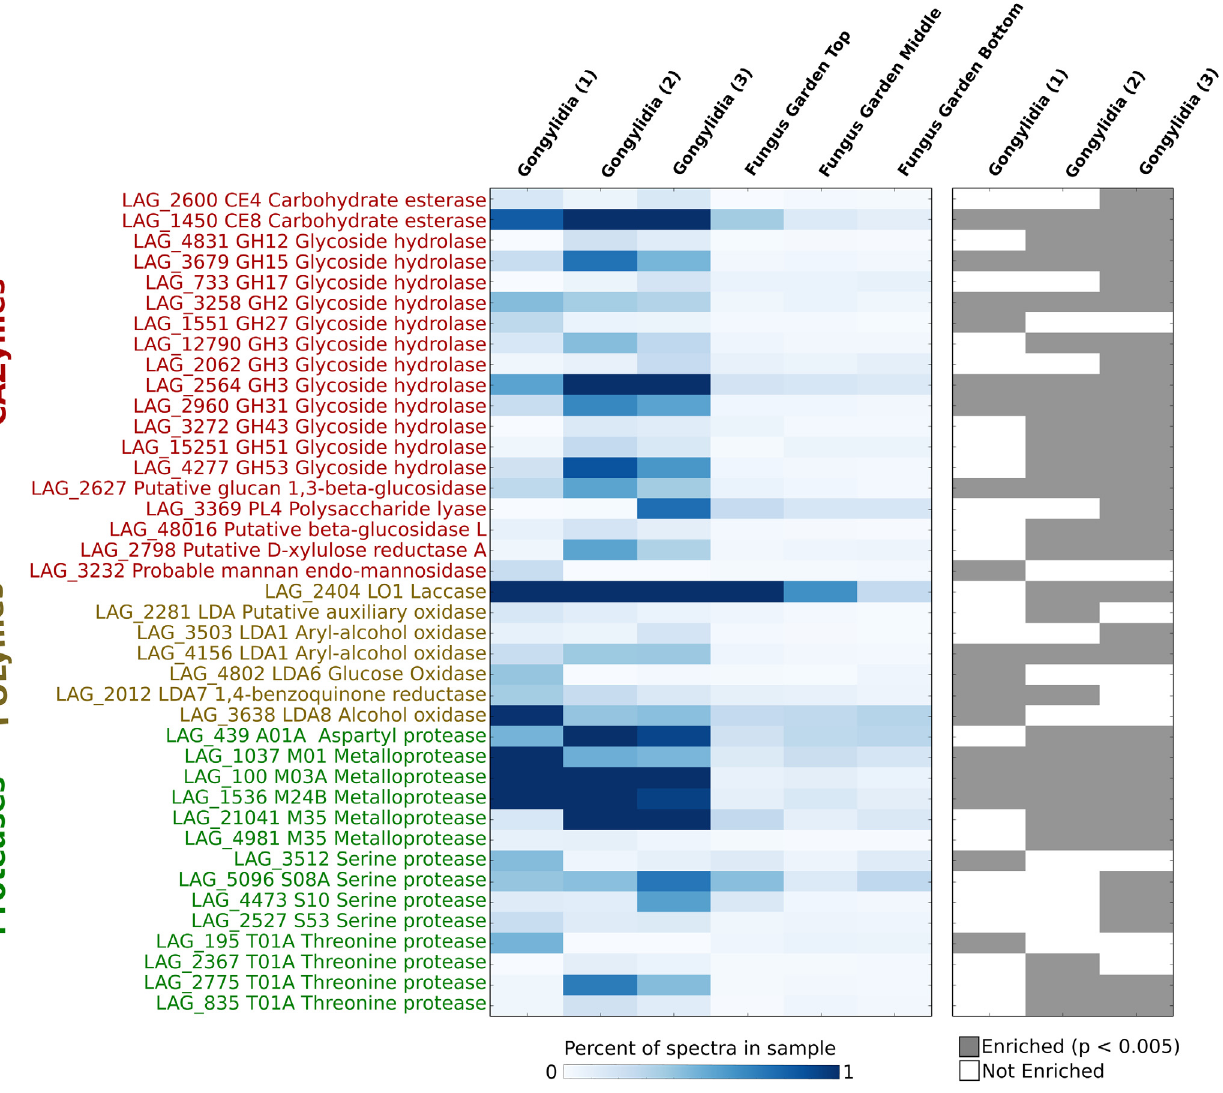
Fig 4. Heatmaps are presented that show the relative percent of total spectra that could be mapped to specific CAZymes, FOLymes, and proteases (left) and those enzymes that were found to be enriched in at least one gongylidia sample (right; Fisher ’ s Exact Test, p < 0.005). Only enzymes identified as enriched in at least one gongylidia sample compared to all fungus garden samples combined are